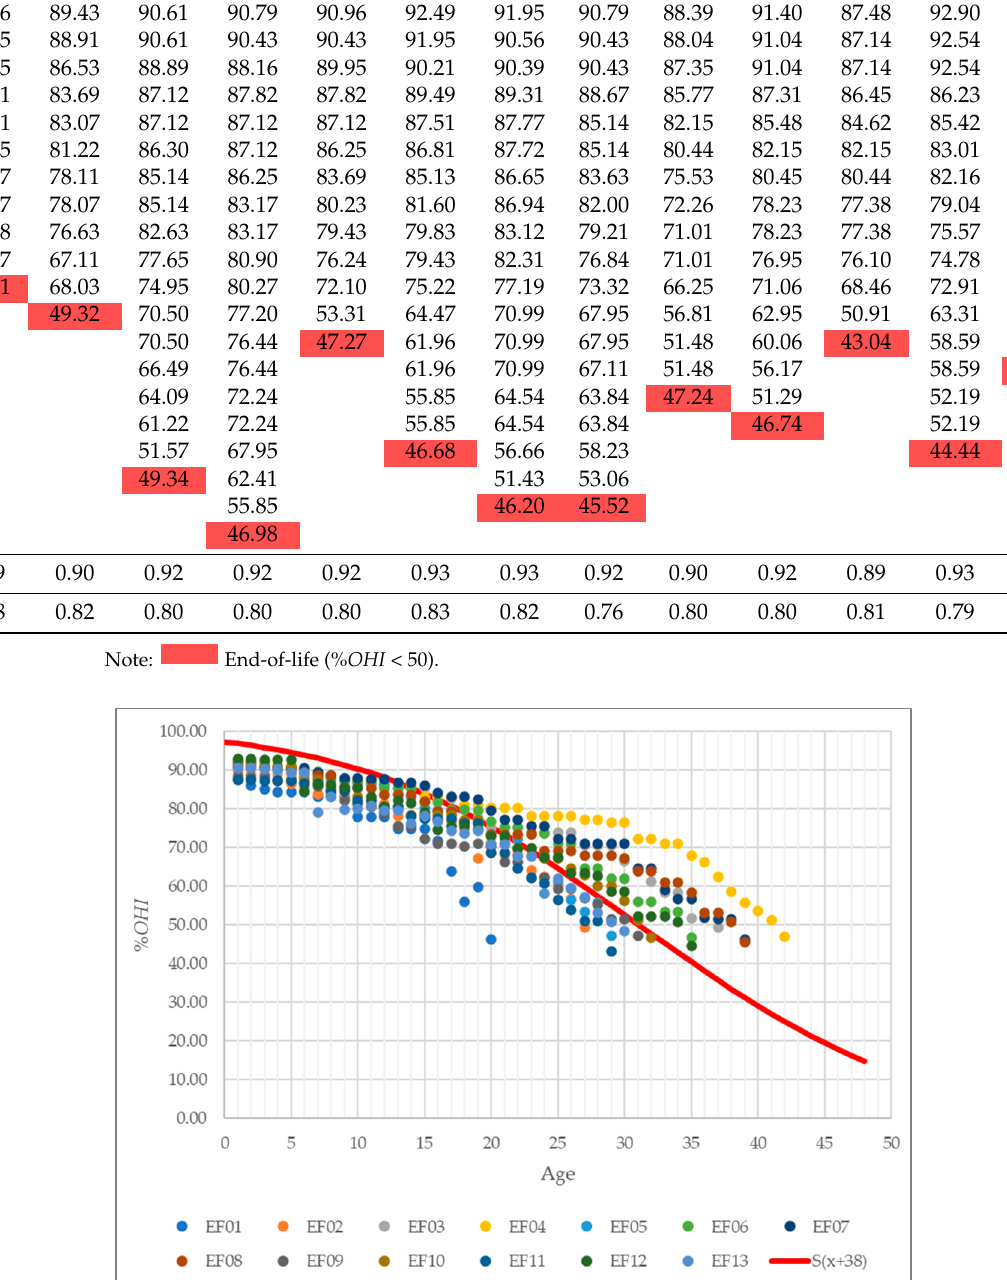
Figure 7. All the % OHI records of 13 retired underground cable systems. Table 6. Statistical % OHI records of 13 retired underground cable systems.